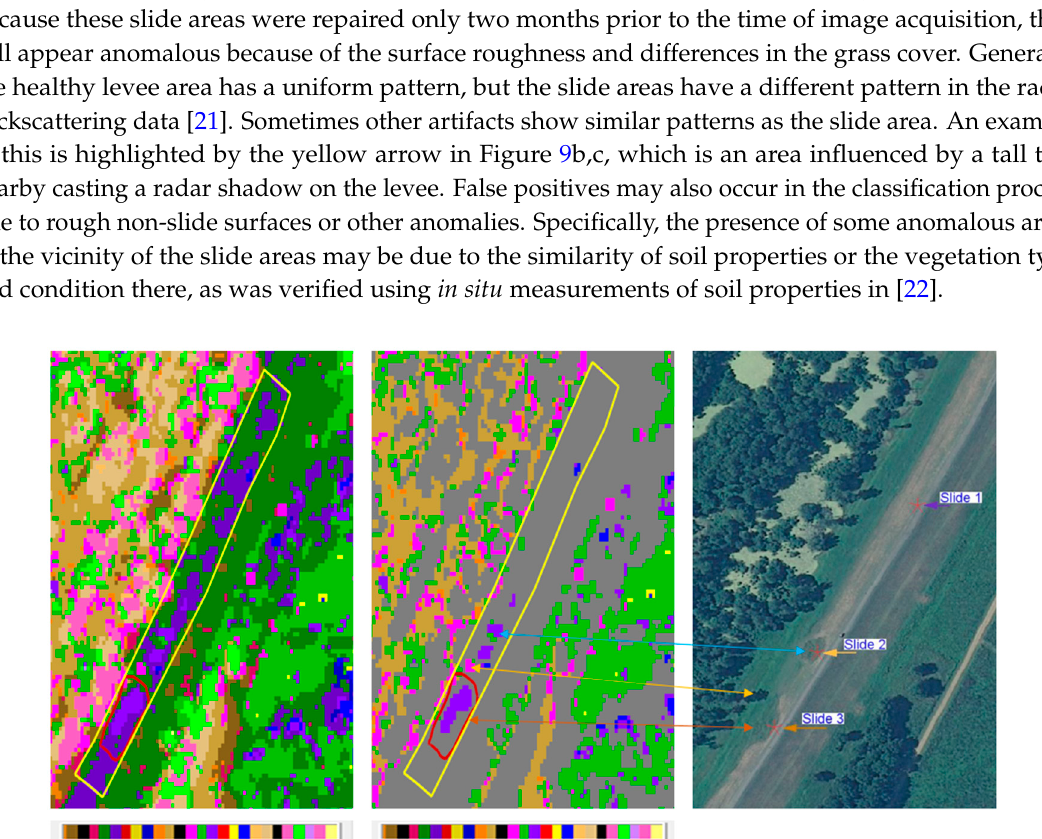
2 classification, and optical